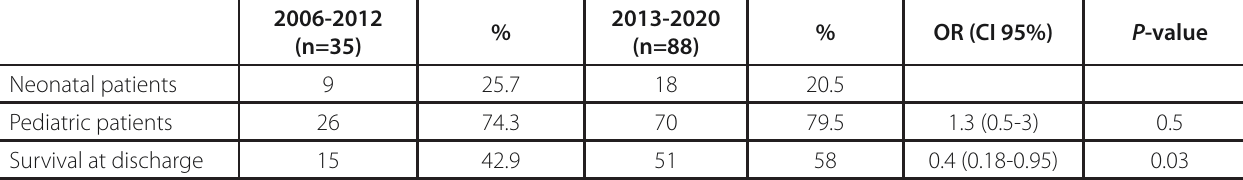
Table 1. ECMO survival at discharge, comparison between the two